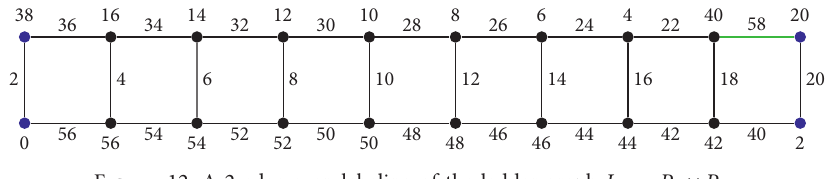
Figure 11: The ladder graph L